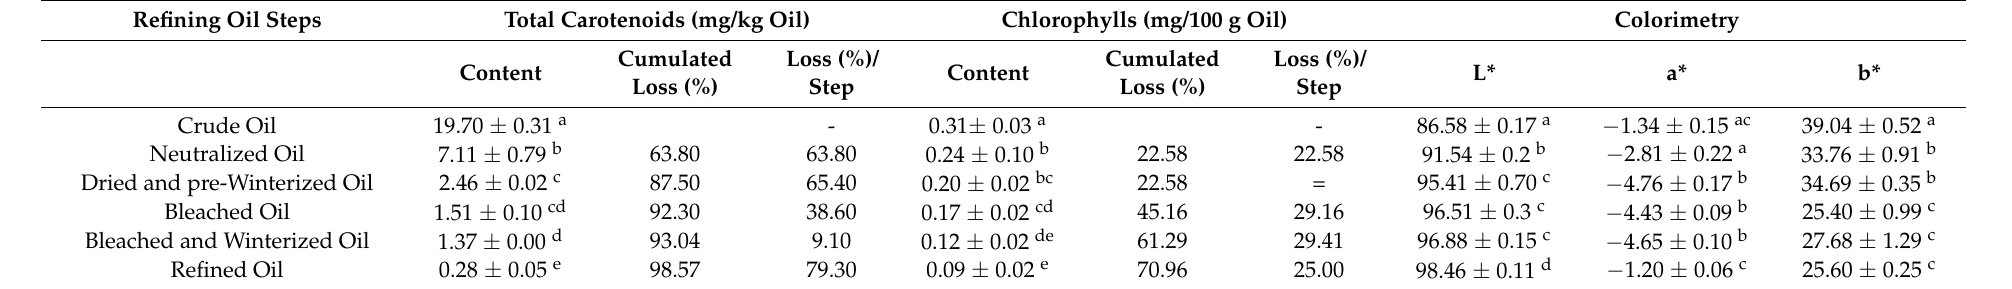
Table 2. Evolution of the color of the oil during the refining process measured in terms of total carotenoid content, chlorophylls and the CIE L*a*b* color